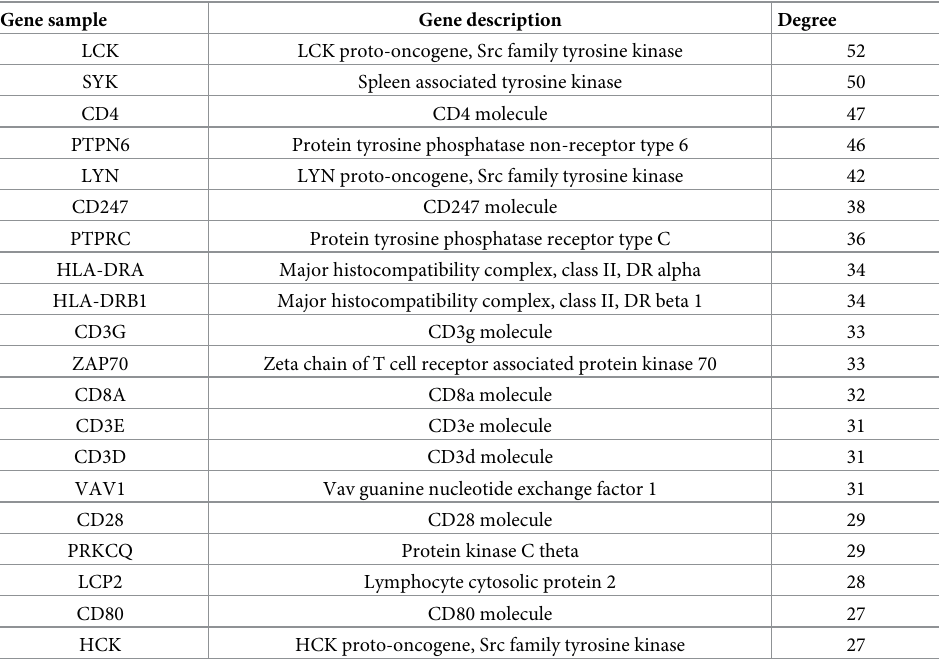
Table 1. Top 20 hub genes with higher connectivity degree in the PPI